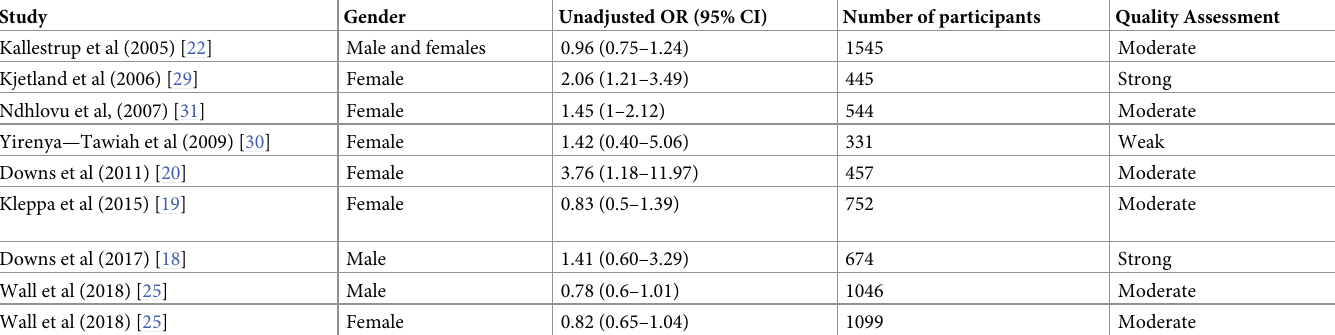
Table 2. Summary of unadjusted OR and quality score of the 8 shortlisted papers.